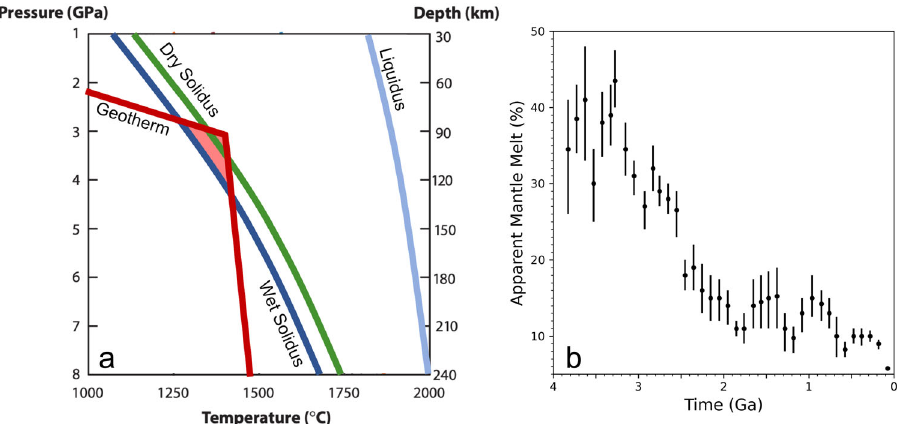
Fig. 1 The extent of mantle melting is controlled by the relative position of a few thermal pro fi les and is constrained over Earth ’ s history. a The position of the Earths mean oceanic geotherm (red) relative to the dry (green) and wet solidus (dark blue) and liquidus (light blue) of the upper mantle. The geotherm is calculated for a present-day heat fl ow of 35 TW and a mantle potential temperature of 1350 °C (see “ Methods ” ). The melting curves represent the dry solidus 39 and wet solidus 15 assuming 2.5 ocean masses in the mantle. b Apparent mantle melt fraction (dots as means and bars as uncertainty) from continental arcs over geologic history. 2,28